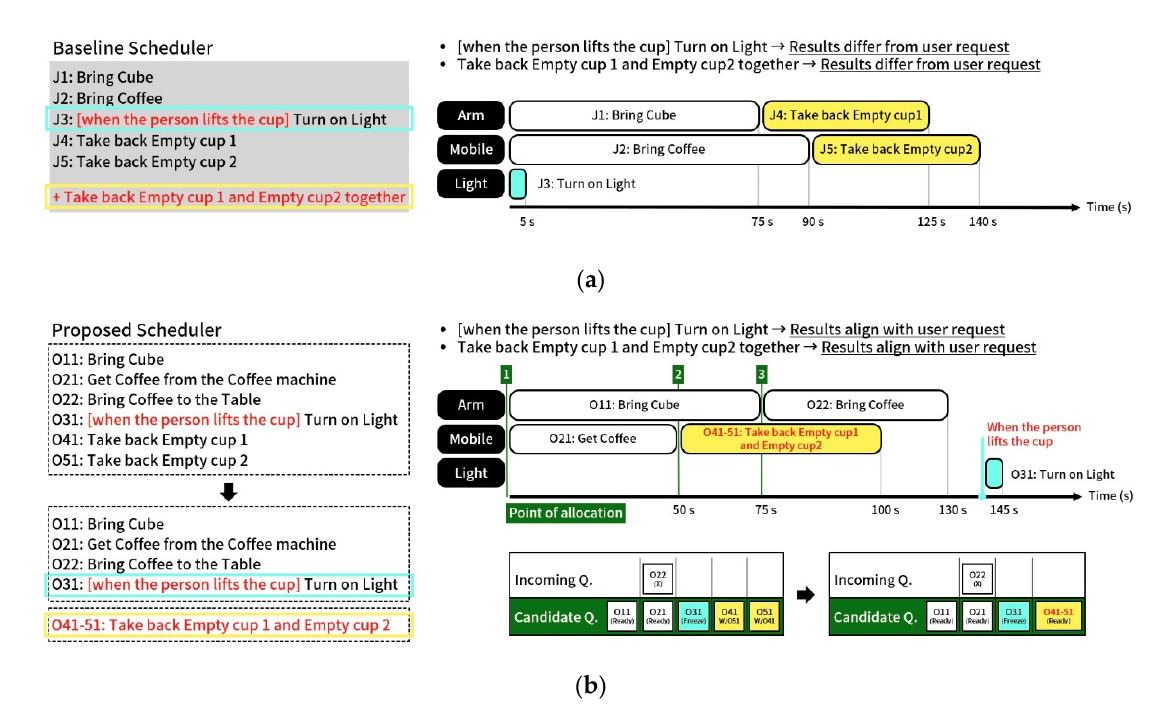
Figure 7. Preferred time and simultaneous request: ( a ) the baseline scheduler and ( b ) the proposed scheduler.